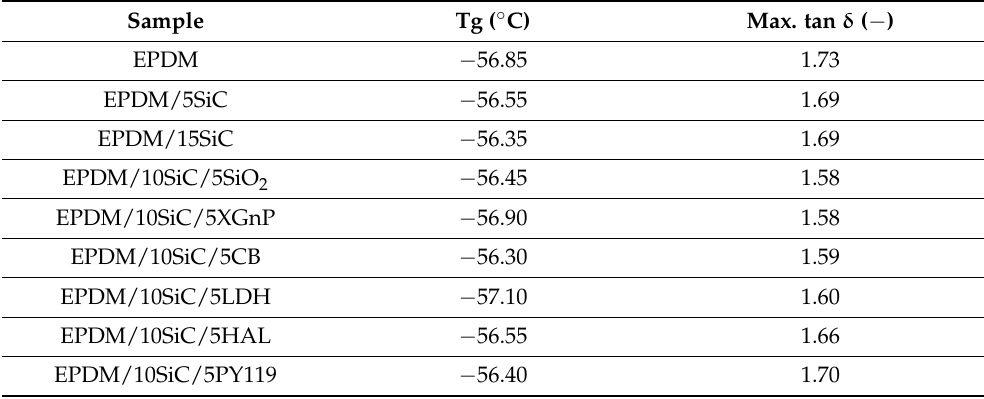
Table 3. Glass transition temperatures (Tg) and maximum tan δ values for different EPDM composites in DMA measurements.